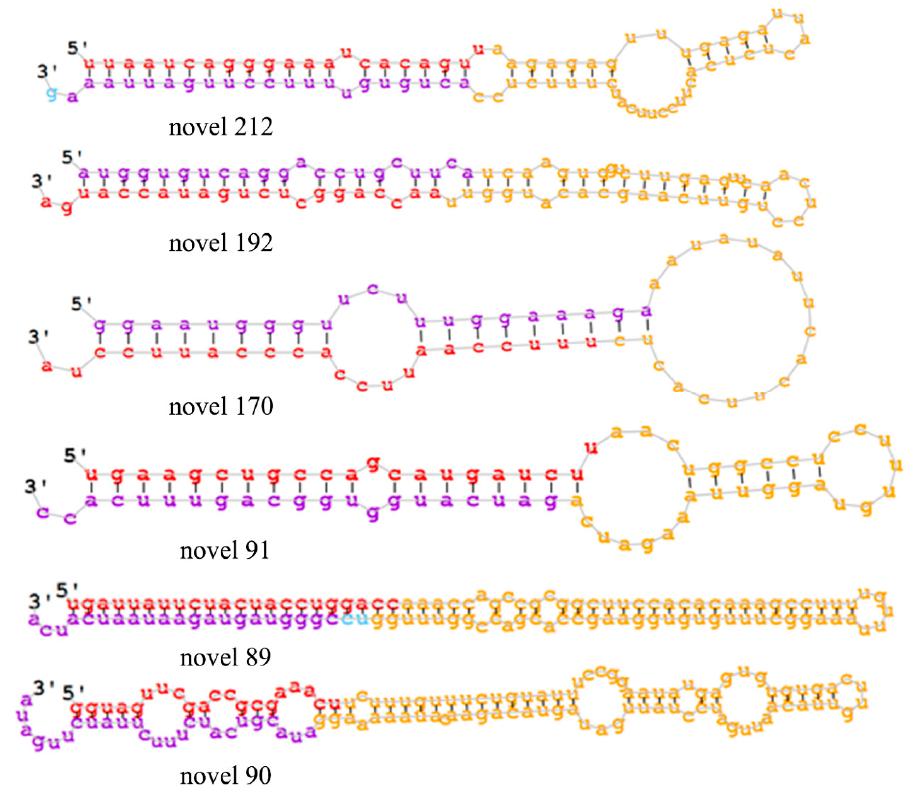
Figure 3. The stem-loop structure of six novel miRNA precursors with most abundant expression. Mature miRNA sequences are signed in red and miRNA* are marked in purple. Table 1. Overview of small RNA sequences in nine R108